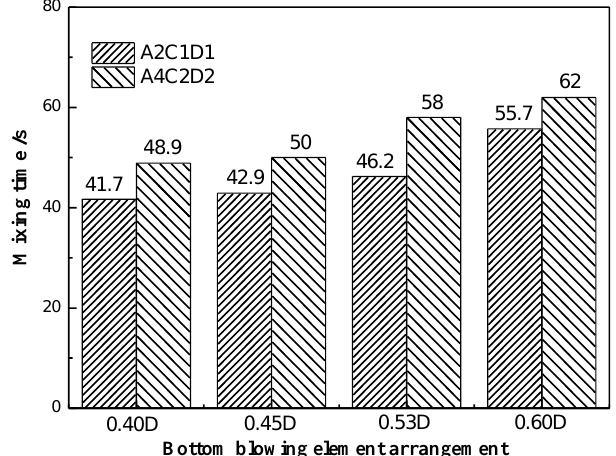
Figure 4. Determination of the effect of different bottom blowing element arrangements on the mixing time.